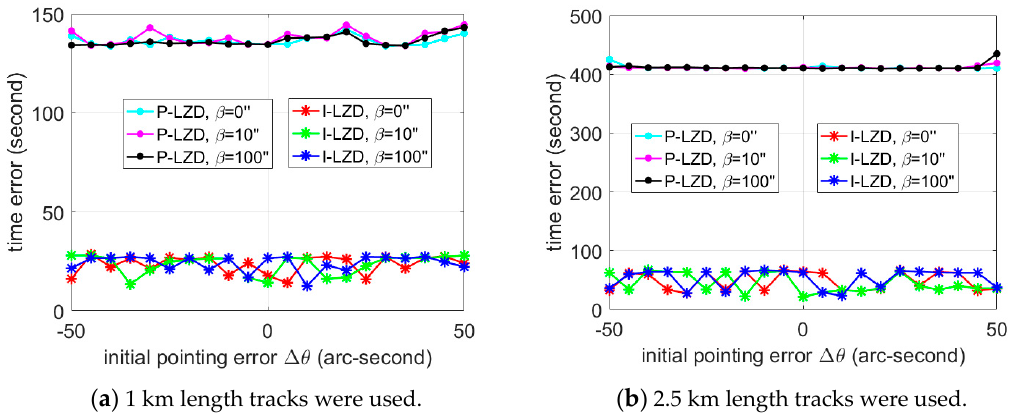
Figure 9. The calibration time taken by the P-LZD and I-LZD algorithms with different initial errors of θ and β .